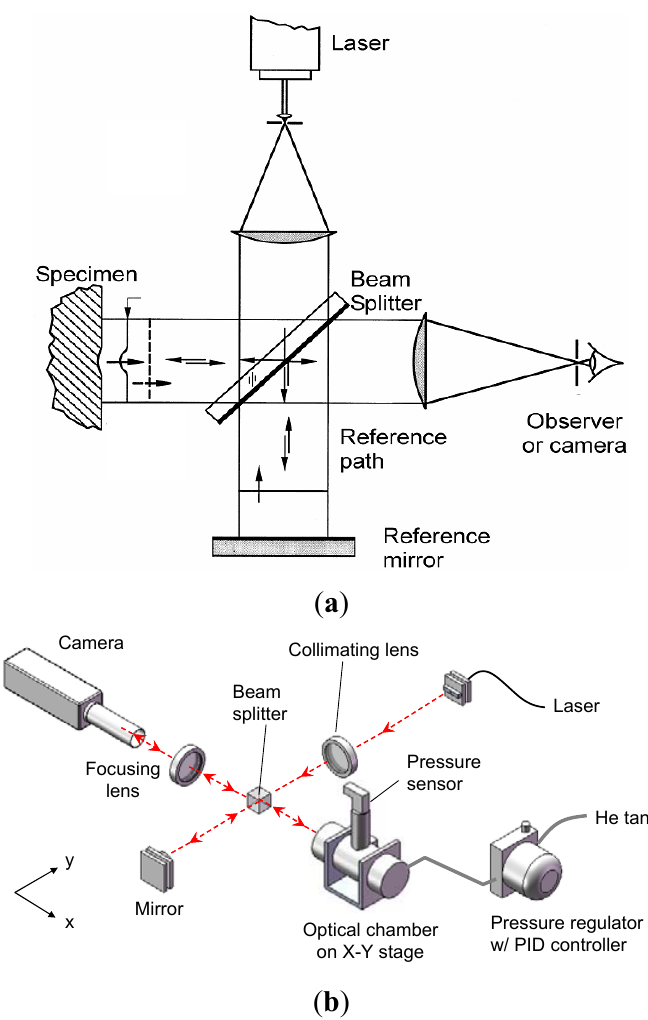
Figure 9. Schematic illustration of ( a ) Twyman-Green interferometry and ( b ) the experimental